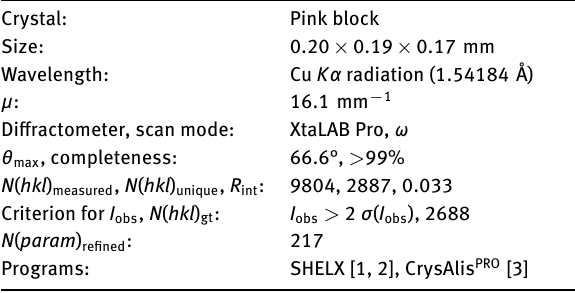
Table 2: Fractional atomic coordinates and isotropic or